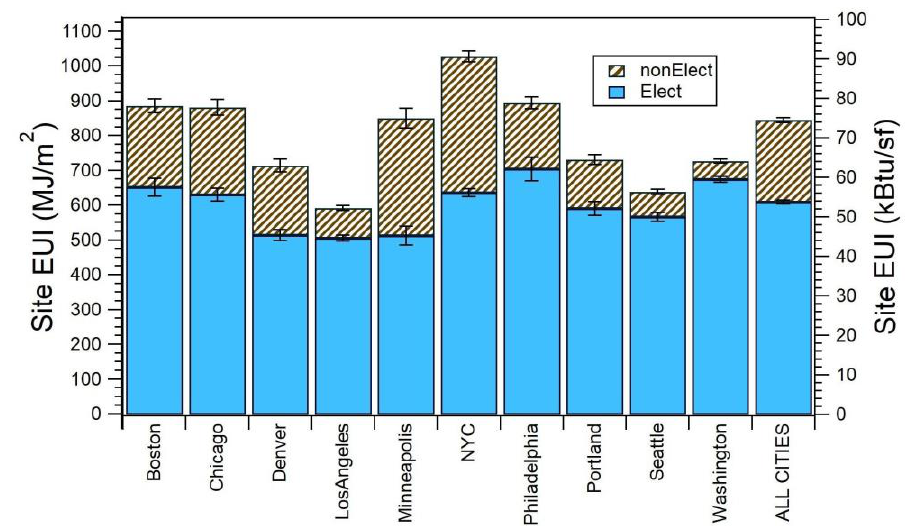
Figure 1. Area-weighted mean site energy use intensity (EUI) for offices in ten cities and in aggregate (ALL CITIES). Electric EUI contribution is shown in blue and non-electric in brown. Error bars represent bootstrap standard deviations of means.